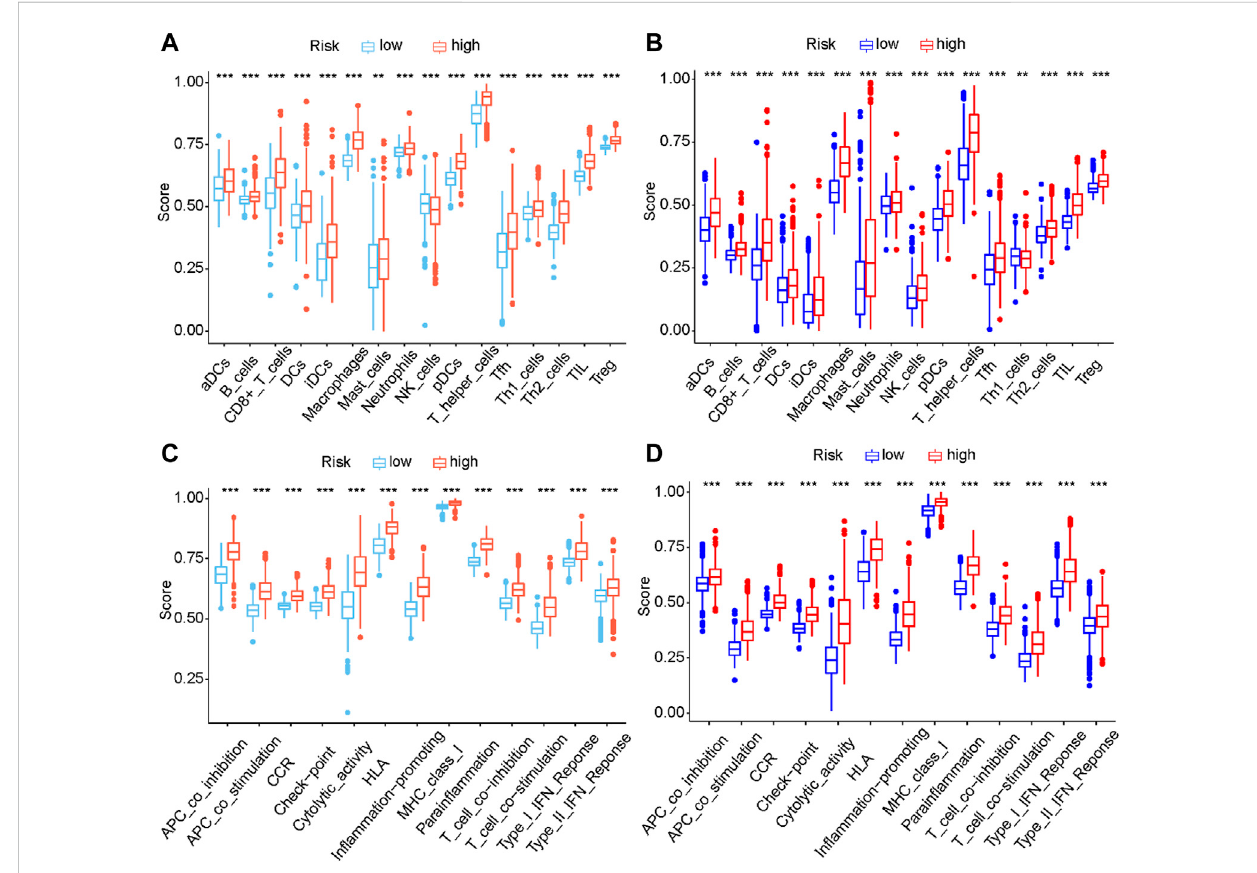
FIGURE 9 ComparisonofthessGSEAscoresbetweendifferentriskgroupsintheTCGAcohort (A,C) andCGGAcohort (B,D) Thescoresofsixteenimmunecell types (A, B) and thirteen immune-related functions (C, D) were displayed in boxplots. (aDC, Activated dendritic cell; iDC, Immature dendritic cell; pDC, Plasmacytoiddendriticcell;Tfh,Tfollicularhelpercell;Th2,Thelper2;TIL,Tumorin fi ltratinglymphocyte;Treg,RegulateryTCell;HLA,Humanleukocyte antigen; APC, Antigen presenting cell; CCR, Cytokine-cytokine receptor; Adjusted p values were showed as: ns, not signi fi cant; ***, p <